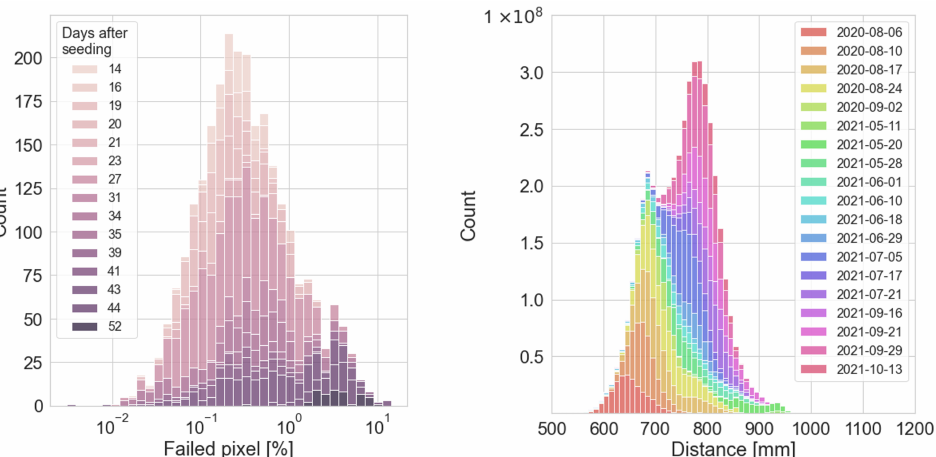
Figure 3. Distribution of failed pixels (in percent) per image colored by days after seeding on logarithmic x-axis ( left ). Distribution of valid distance values (inmm) of the 2568 WE3DS distance maps colored by measurement date ( right